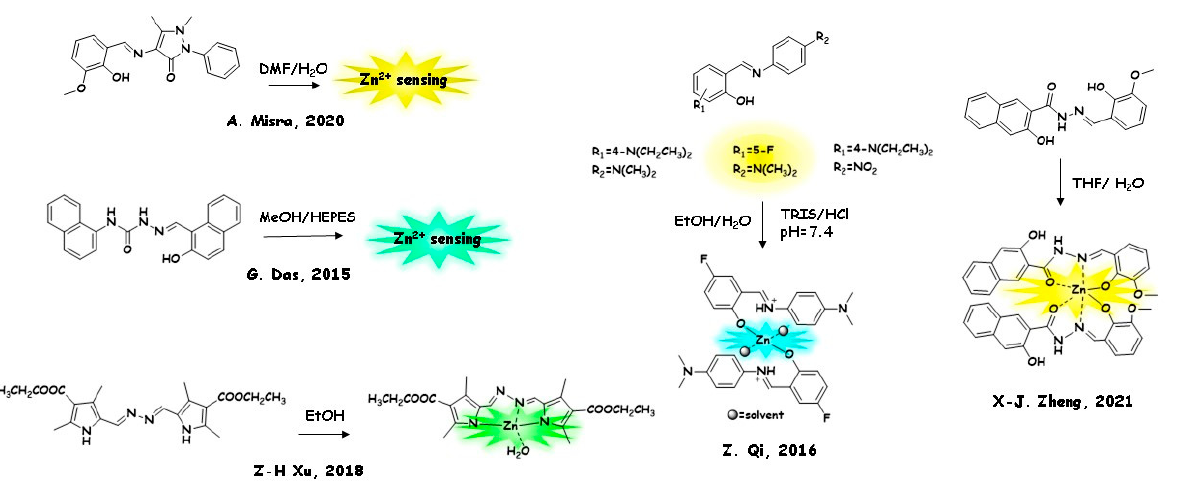
Figure 5. AIEgens acting as zinc (II) multi-channel sensor.